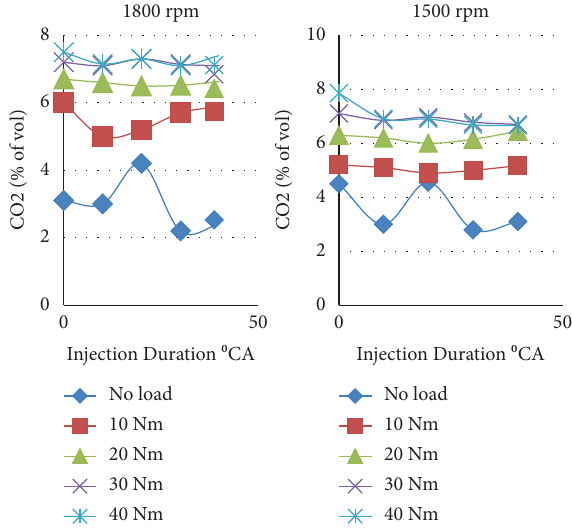
Figure 8: Carbon dioxide for diferent H speeds at 1500rpm and